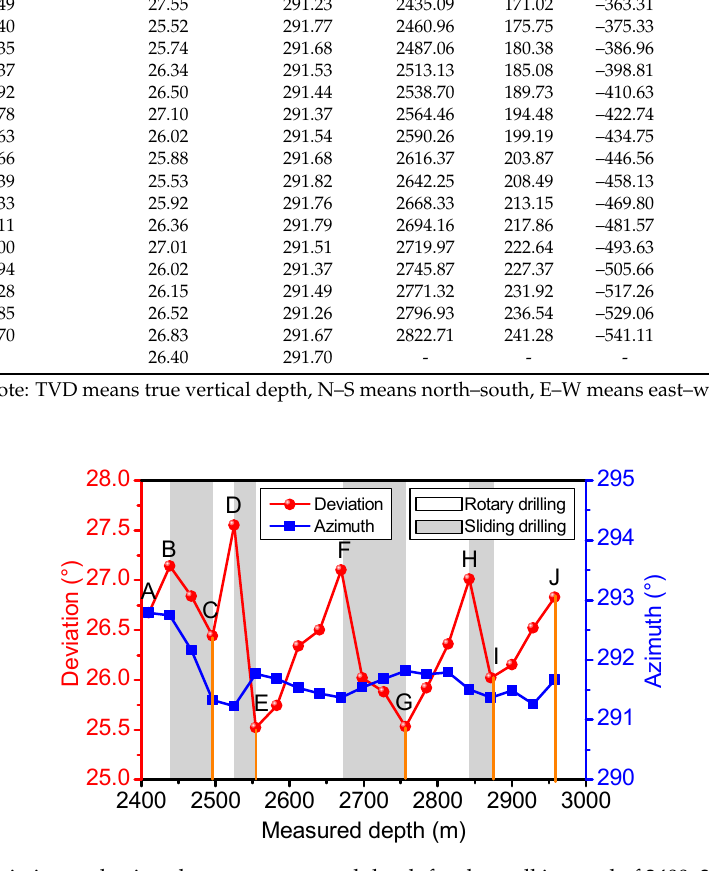
Figure 13. Deviation and azimuth versus measured depth for the well interval of 2400–3000 m in well B. Table 3. The trajectory of test interval in well B.